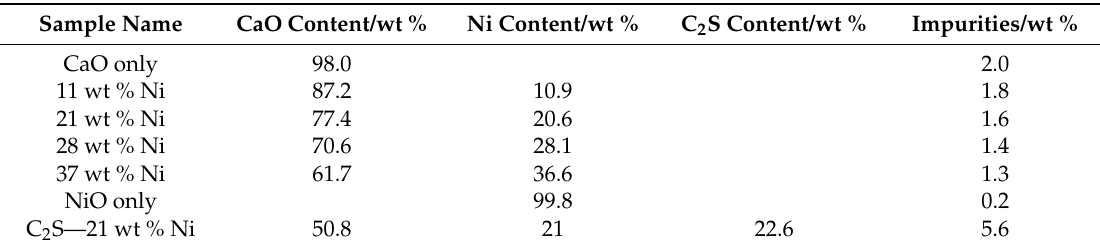
Table 2. Summary of combined particles